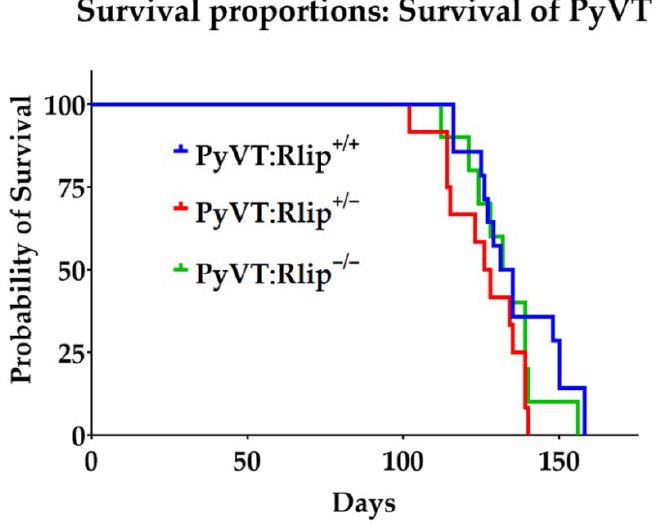
Figure 3. Rlip deficiency does not prevent spontaneous carcinogenesis in viral MMTV-PyVT mouse model. Overall survival curves for mice of the indicated genotypes are shown. No treatment was given, and the mice were euthanized when tumor volume reached 2000 mm 3 . Results are reported as mean ± SD (PyVT:Rlip +/+ ( n = 14); PyVT:Rlip − / − ( n = 12) and PyVT:Rlip +/ − ( n = 10)).